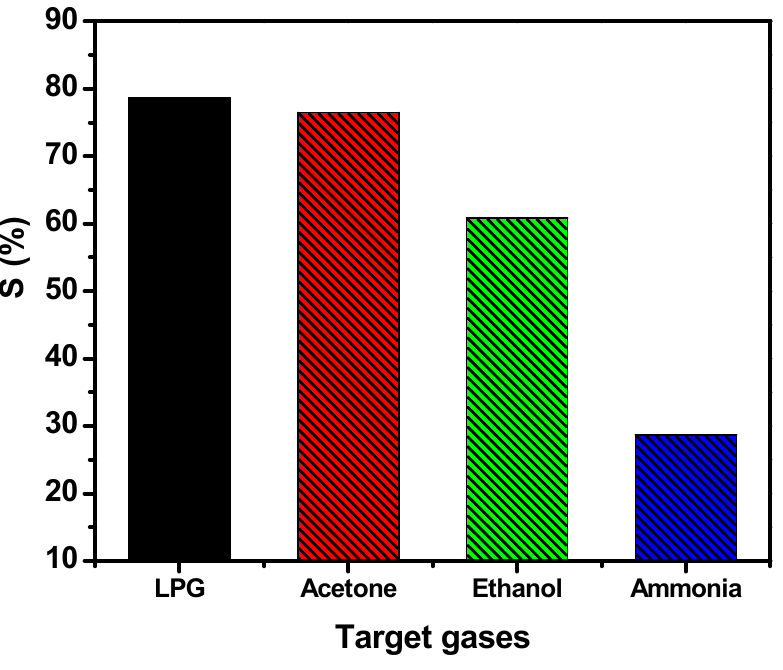
Figure 7. Selectivity test of the developed MgFe 2 O 4 .